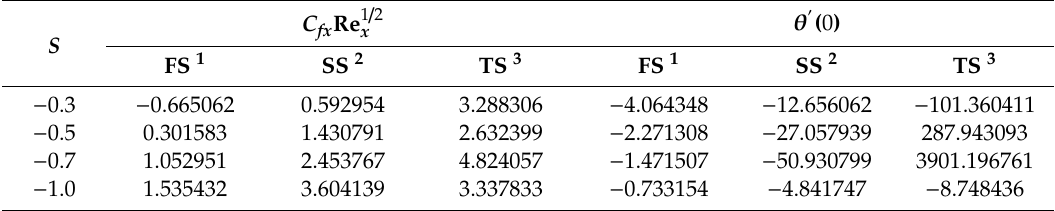
Table 8. Value of Table 8. Value of C fx Re 1/2 x